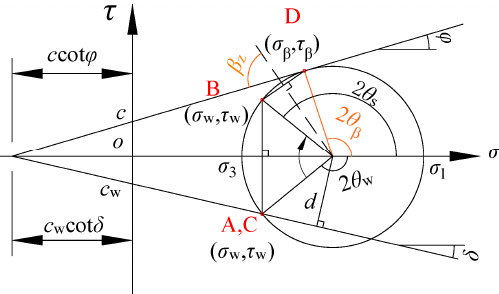
Figure 3. Mohr stress circle analysis.